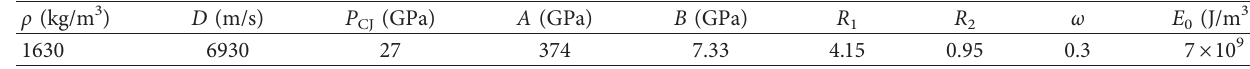
Table 4: Parameters of the explosive in the numerically stimulation experiment.